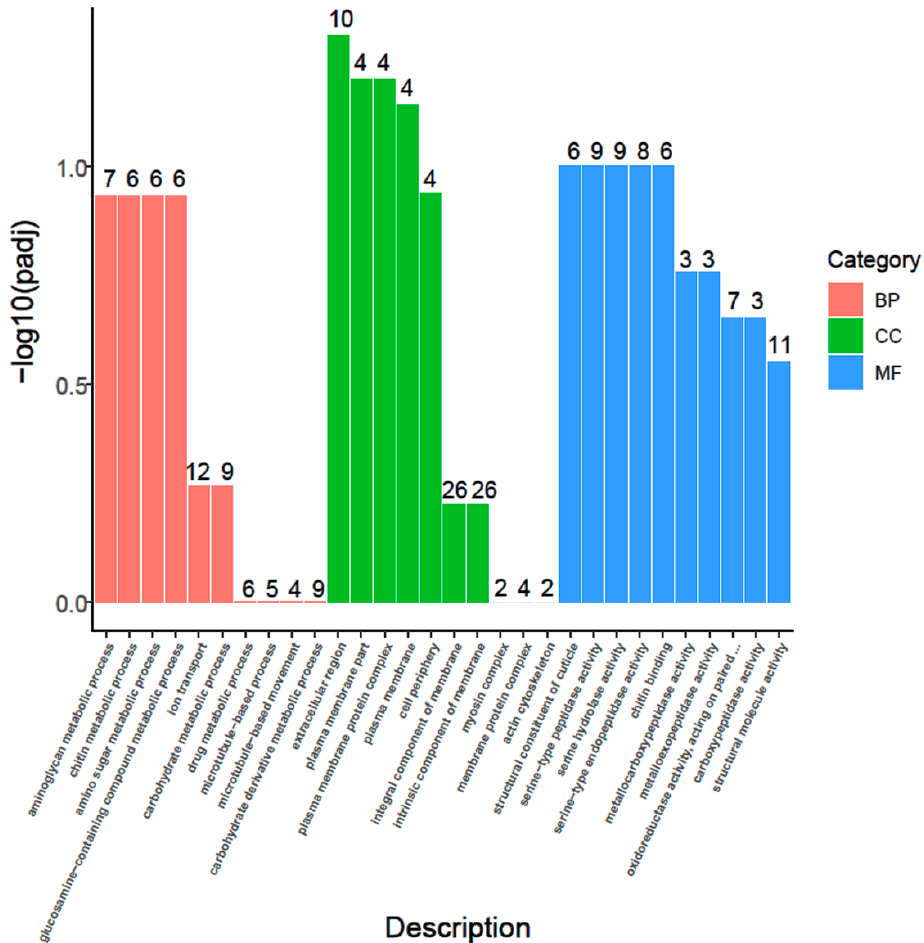
Figure 5. GO enrichment result of the differentially expressed unigenes (DEGs) in honeybee larvae from the EMF group and CK group. GO enrichment result showed that the ELF-EMF exposure mainly interfere the structure and function of plasma membrane, the structural constituent and function of cuticle, and variety of peptidase activity.